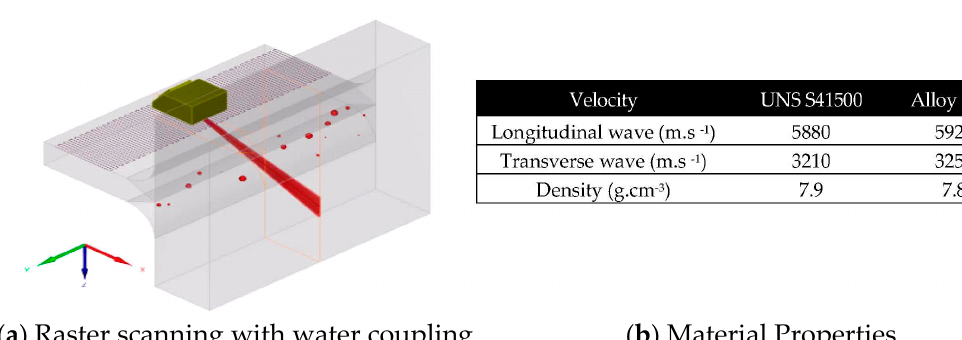
Figure 8. Parameters of the ultrasonic probe.